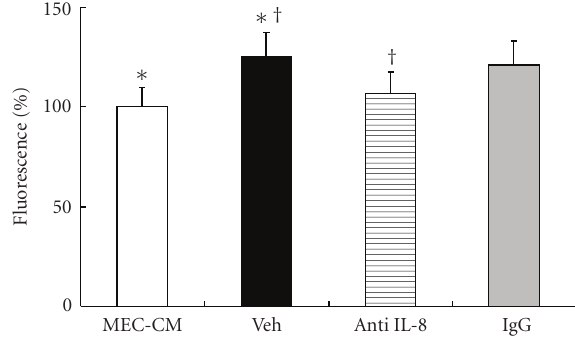
Figure 4: Changes of the expression of CD11/CD18 by anti-IL-8 antibody. The percentage of fluorescent intensity was significantly higher in the 10 SP/MEC-CM (Veh group) than in the MEC-CM. The fluorescent intensity in SP/MEC-CM treated with anti-IL-8 antibody was significantly less than that in Veh group. ∗ , † P < .